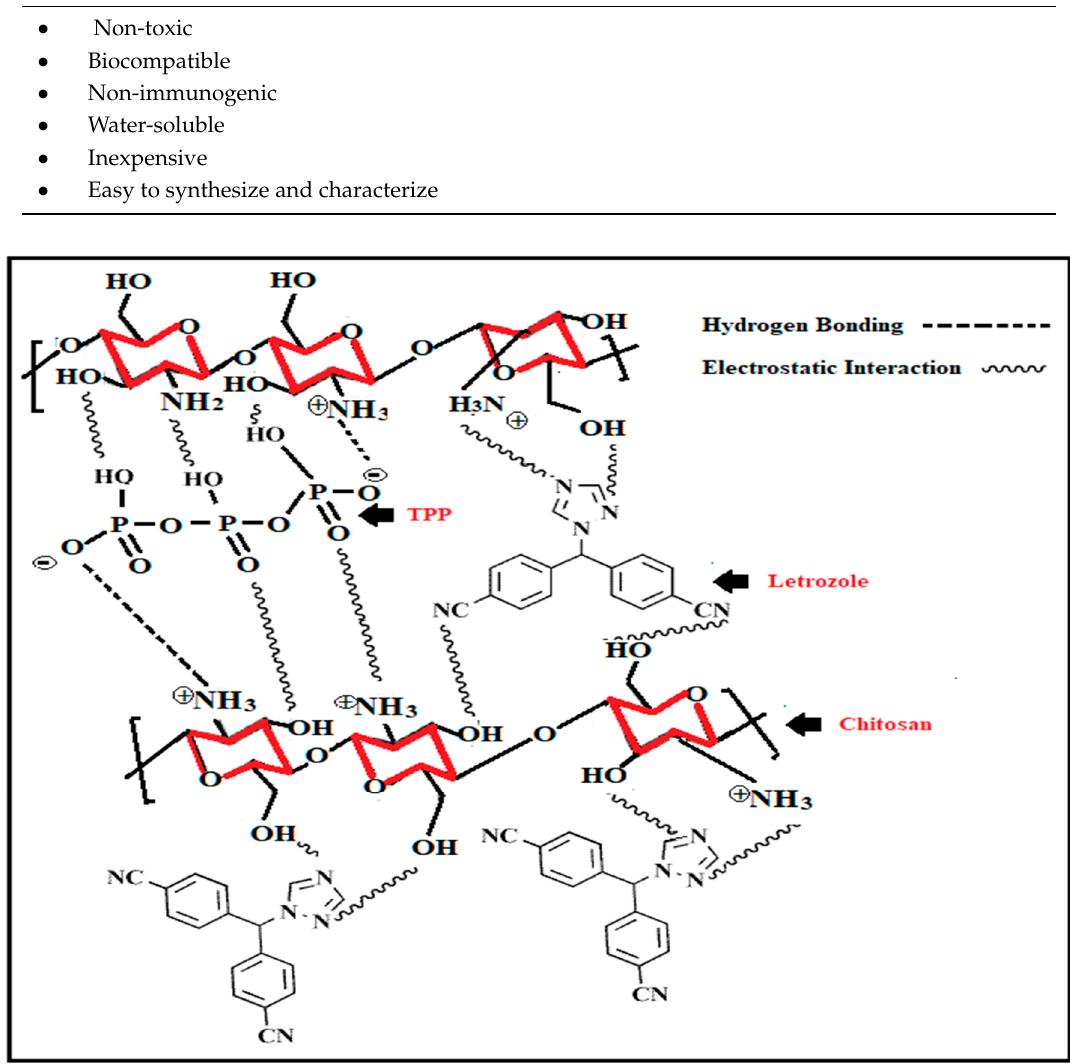
Figure 4. Shows the formation of chitosan nanoparticles modified with tripolyphosphate (TPP)- loaded letrozole [52]. Copyright ©2017,